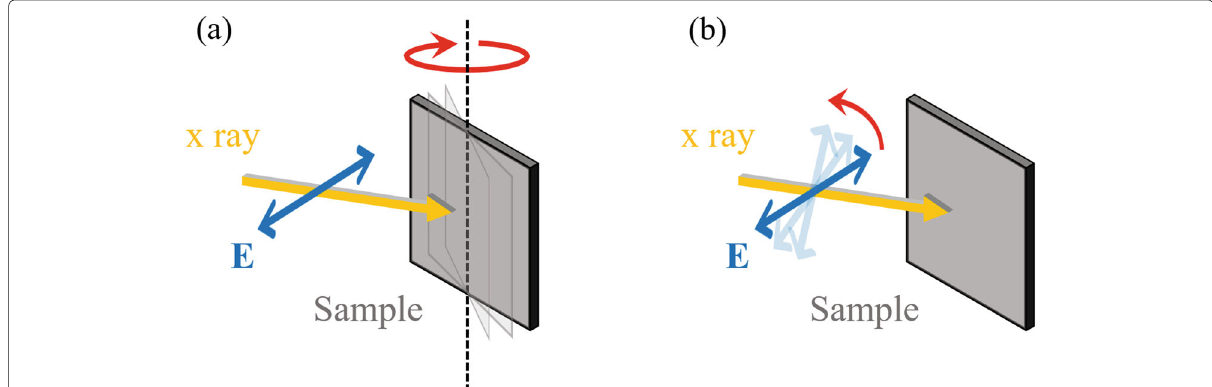
Fig. 27 Measurement setup of NEXAFS. a Conventional method where the sample polar angle is varied. b Our approach to rotate the azimuthal angle of linear polarization while fixing the sample position and